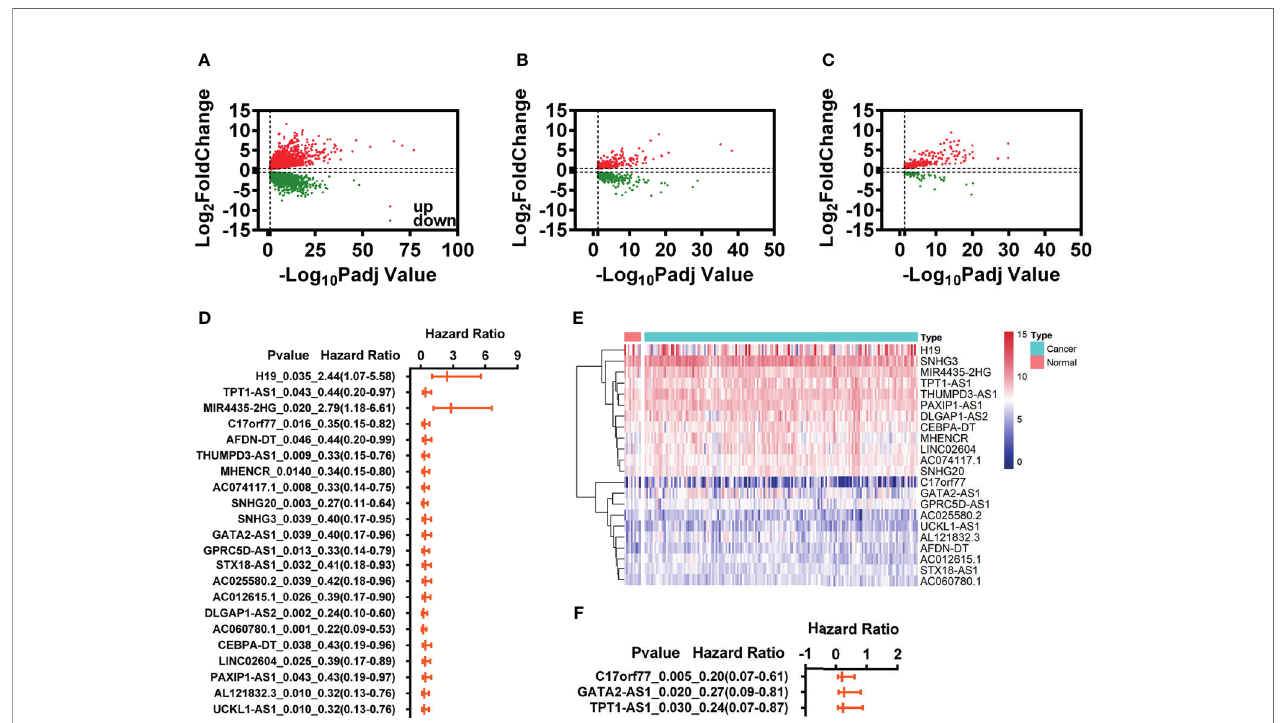
FIGURE 1 | Identi fi cation of immune-related differential expression lncRNAs (IR-DELs). (A) Volcano plot of DEGs for READ. (B) Volcano plot of IR-DEGs for READ. (C) Volcano plot of DELs for READ. (D) The univariate Cox regression analysis for those 22 IR-DELs. (E) The heatmap of 22 IR-DELs veri fi ed by univariate Cox regression analysis. (F) The multivariate Cox regression analysis for those three